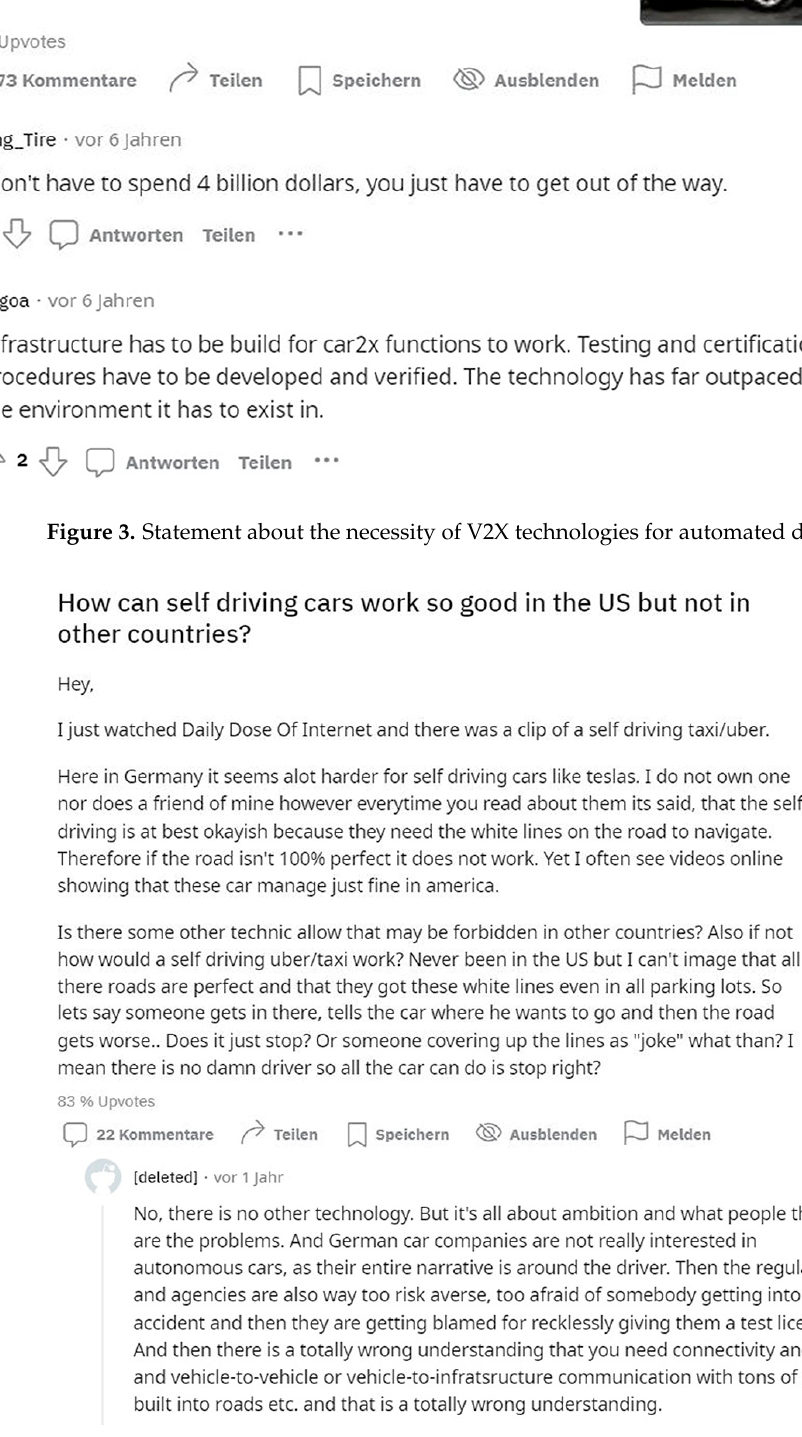
Figure 4. Skeptical opinion about the necessity of V2X technologies for automated driving.